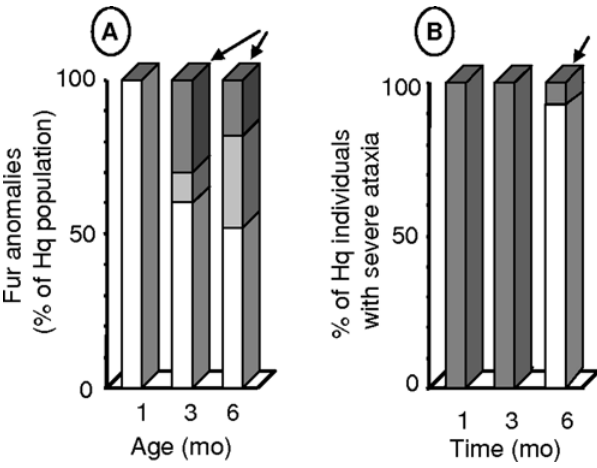
Figure 2. Variability of baldness and ataxia severity in Harlequin mice. A: Baldness in Hq mice. Open bars indicate severe baldness (more than 70% of the body surface area) at ages when controls had their full adult coat. Gray bars indicate patchy baldness (less than 30% of the body surface area). Patch distribution varied across animals. Dark bars represent animals with a full coat, many of which had sparser hair than the controls. The arrow shows that a substantial proportion of Hq mice had nearly normal hair at 3 and 6 mo of age. B: Severe ataxia in Hq animals (open bars; three or more falls in 5 minutes) was detected only at 6 mo of age. The arrow shows that two Hq animals had only mild ataxia at 6 mo of age.